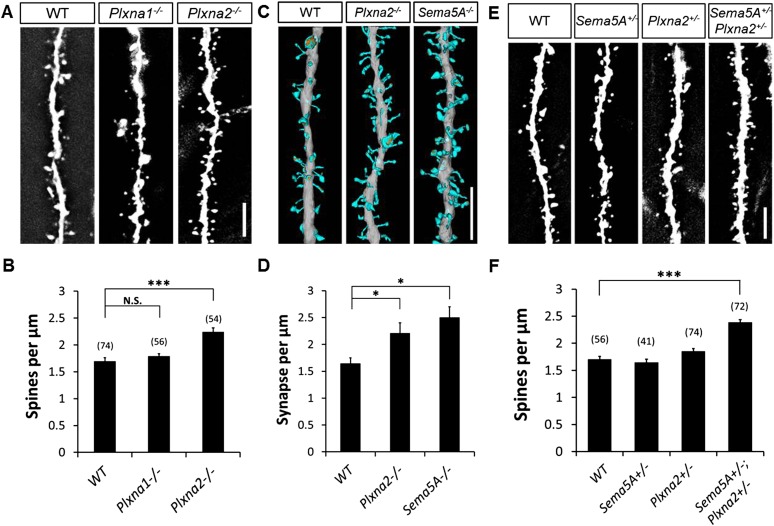
Sema5A and Plxna2 genetically interact, and Plxna2−/− and Sema5A−/− mice show increased synapse density in dentate GCs.(A) Representative images of outer dendritic segments of GCs from P30 Thy1-eGFPm WT, Plxna1−/− and Plxna2−/− hippocampal sections. (B) Quantification of GC dendritic spine density reveals a significant increase in Plxna2−/− mice compared to Plxna1−/− and WT controls. Numbers in brackets indicate the dendritic segments analyzed per condition. Values are represented as mean ± SEM from three to four animals of each genotype. ***p < 0.001, two-tailed unpaired Student's t test. (C) Three-dimensional reconstruction of GC dendritic segments from P32 WT, Plxna2−/− and Sema5A−/− mice. The dendritic shaft is colored in gray, dendritic spines in blue and the PSDs in orange. A total of 110, 208, and 165 spines were reconstructed and analyzed for WT, Plxna2−/− and Sema5A−/− mice, respectively (n = 1 animal per genotype). (D) Quantification of spine density. Values are represented as mean ± SEM from three to four dendritic segments (each 20 to 22 µm in length) per genotype, *p < 0.05, two-tailed unpaired Student's t test. (E) Representative images of GC dendritic segments of P30 Thy1-eGFPm WT, Sema5A+/−, Plxna2+/−, and compound heterozygous Sema5A+/−; Plxna2+/− mice. (F) Quantification of GC spine densities of genotypes in E reveals significantly more spines in compound heterozygotes than WT and single heterozygotes. Numbers in brackets indicate the number of dendrites analyzed per condition. Values are represented as mean ± SEM from four animals per genotype. ***p < 0.0001, two-tailed unpaired Student's t test. Scale bars in A, C and D = 5 µm.